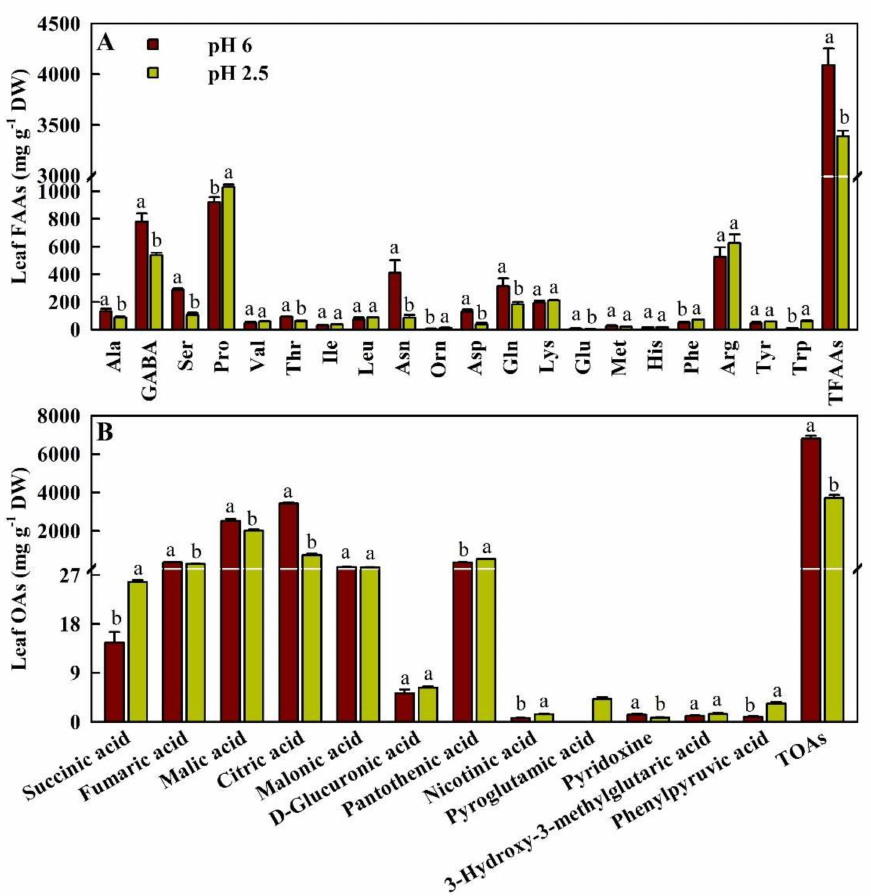
Figure 4. Mean ( ± SE, n = 3) concentrations of 20 free amino acids (FAAs) and total FAAs (TFAAs, the summation of 20 FAAs) ( A ), and 12 organic acids (OAs) and total OAs (TOAs, the summation of 12 OAs) ( B ) detected in pH 2.5 and/or pH 6.0-treated leaves. Pyroglutamic acid (PG) was detected only pH 2.5-treated leaves. Different letters above the bars for the same FAA or OA indicate a significant difference at p <